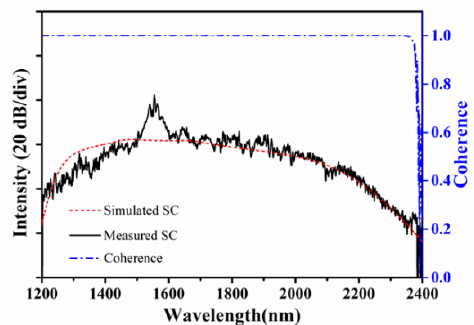
Figure 6. Simulated and measured SC spectrum in the 30 cm TBZL/TWZN fiber and calculated coherence of the SC.